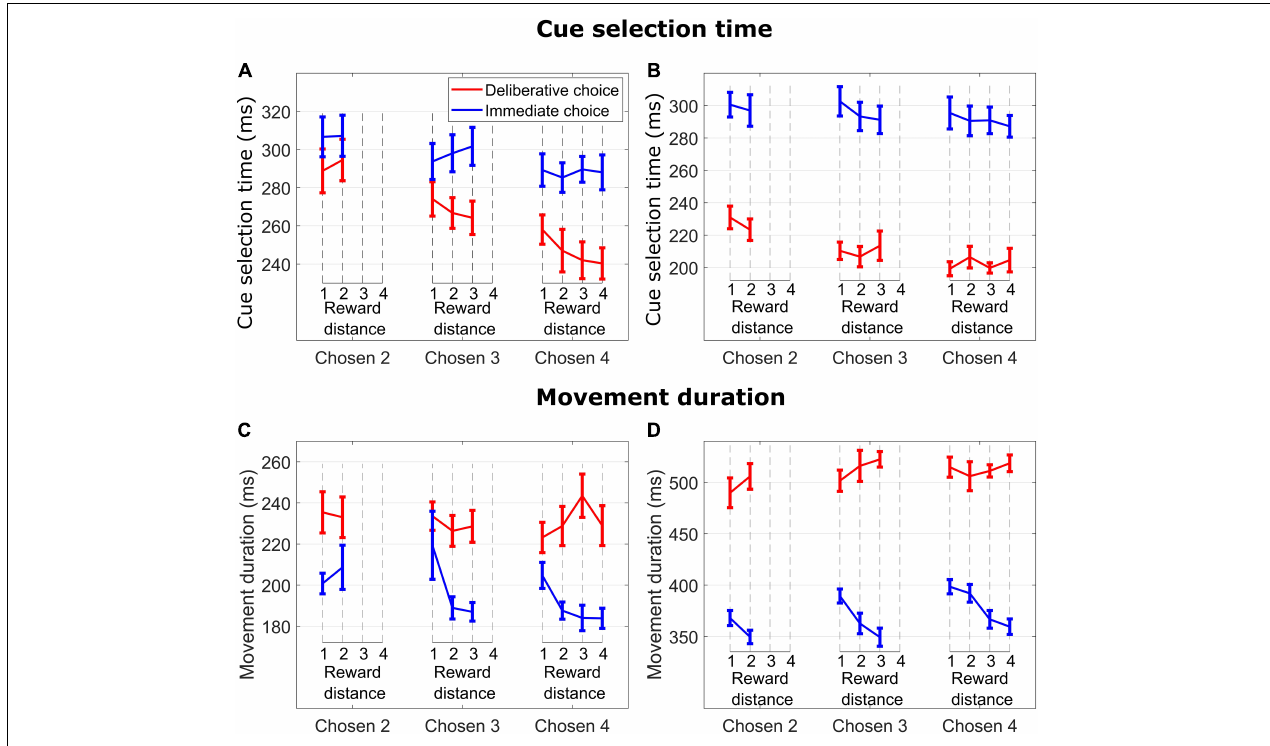
FIGURE 2 | (A) Cue selection time (time from when the cues were presented to when the monkey released the hold button) vs. reward distance (RD) between cues for different Chosen Values for DC (red curves) and IC (blue curves) trials for M1. (B) Same format as in (A) for M2. (C) Movement duration (time from when the monkey released the hold button to when the monkey touched the reward cue) vs. reward distance (RD) between cues for different Chosen Value for DC (red curves) and IC (blue curves) trials for M1. (D) Same format as in (C) for